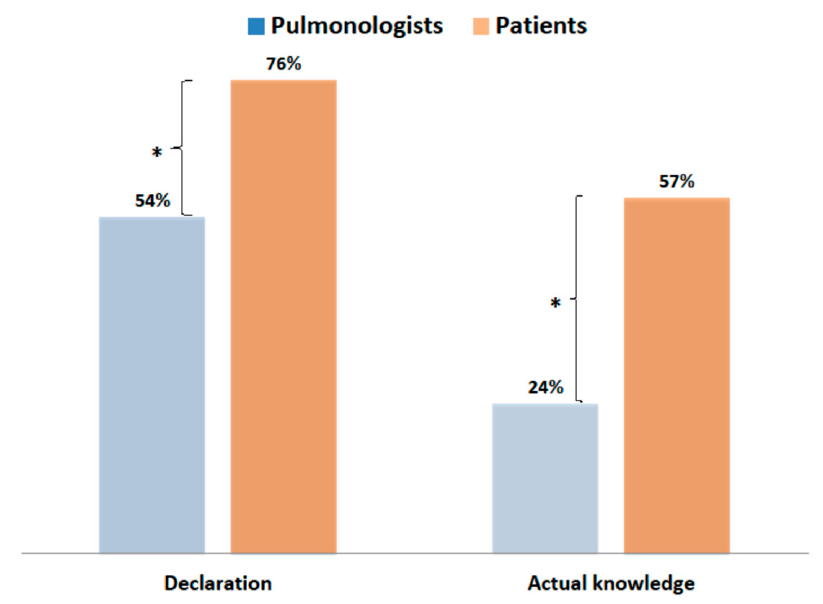
Figure 6. Comparison of the knowledge of patients and that of physicians about the main sources of air pollution in their areas (* p < 0.001).